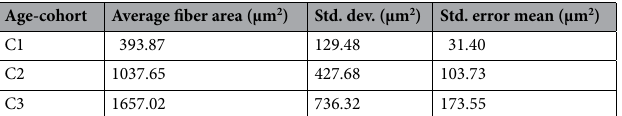
Age-cohort Average fiber area (μm 2 )